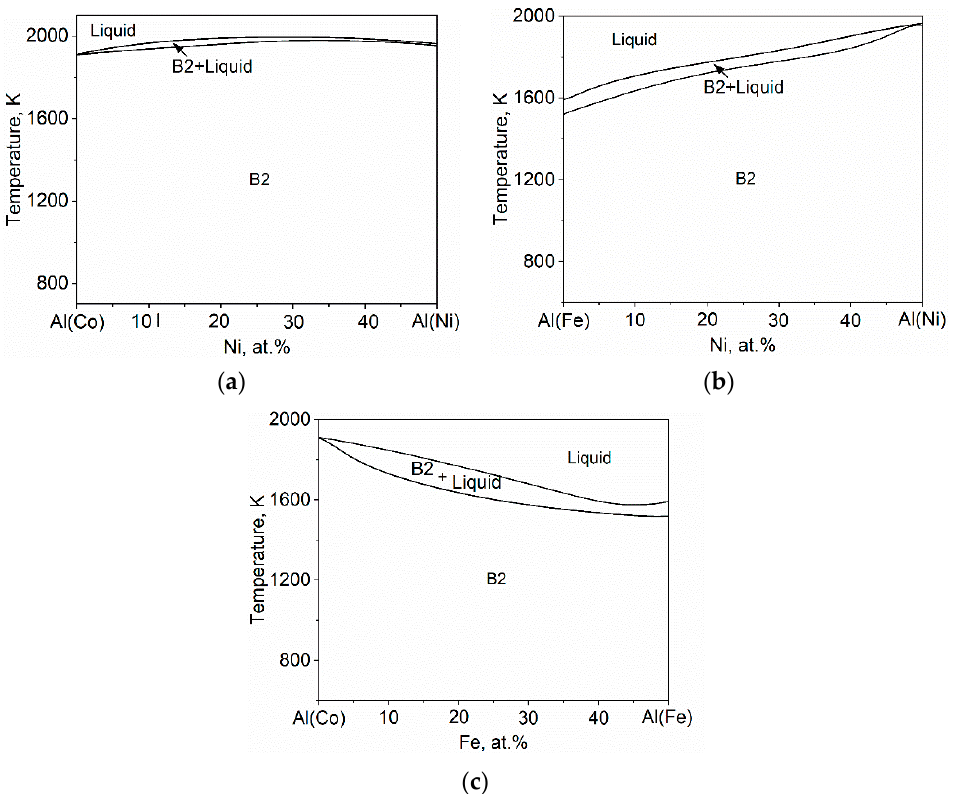
Figure 1. Calculated isopleth sections of ( a ) Al(Co,Ni), ( b ) Al(Fe,Ni), and ( c ) Al(Co,Fe) ternary alloys.